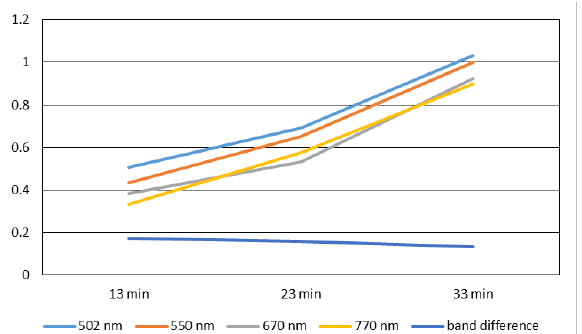
Figure 3. Dark current for 1 ms integration time in four different bands 13, 23, 33 min after sensor switch-on Visual evaluation of the dark current measurements reveal slight spatial inhomogeneity of the DC within on band below one count. This pattern is also reflected in the standard deviation. After the equalize itself to a value of about 0.8 counts.